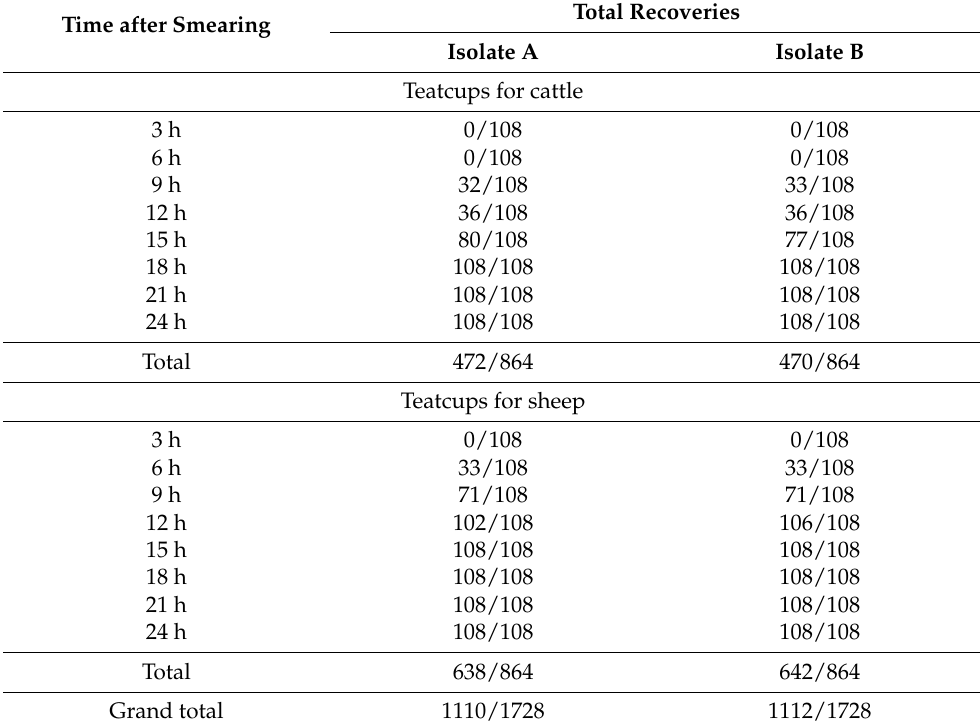
Table 1. Summary of recoveries of two S. epidermidis isolates after smearing on teatcups for cattle or sheep. Total Recoveries Time after Smearing Isolate A Isolate